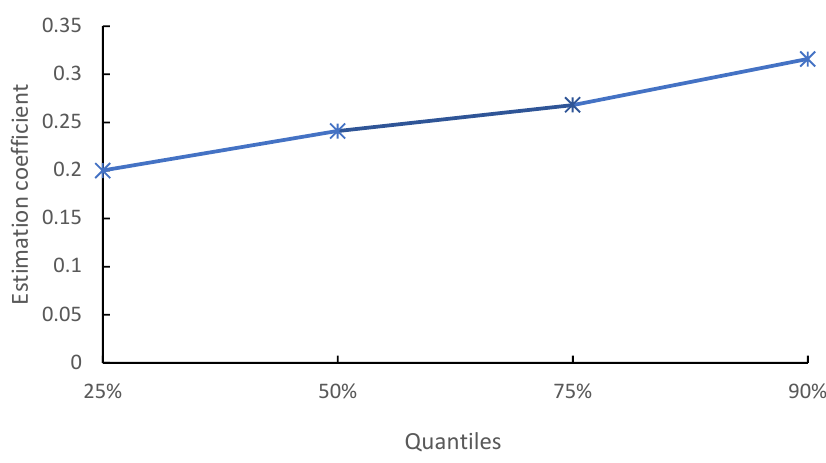
Figure 1. Quantile feature.